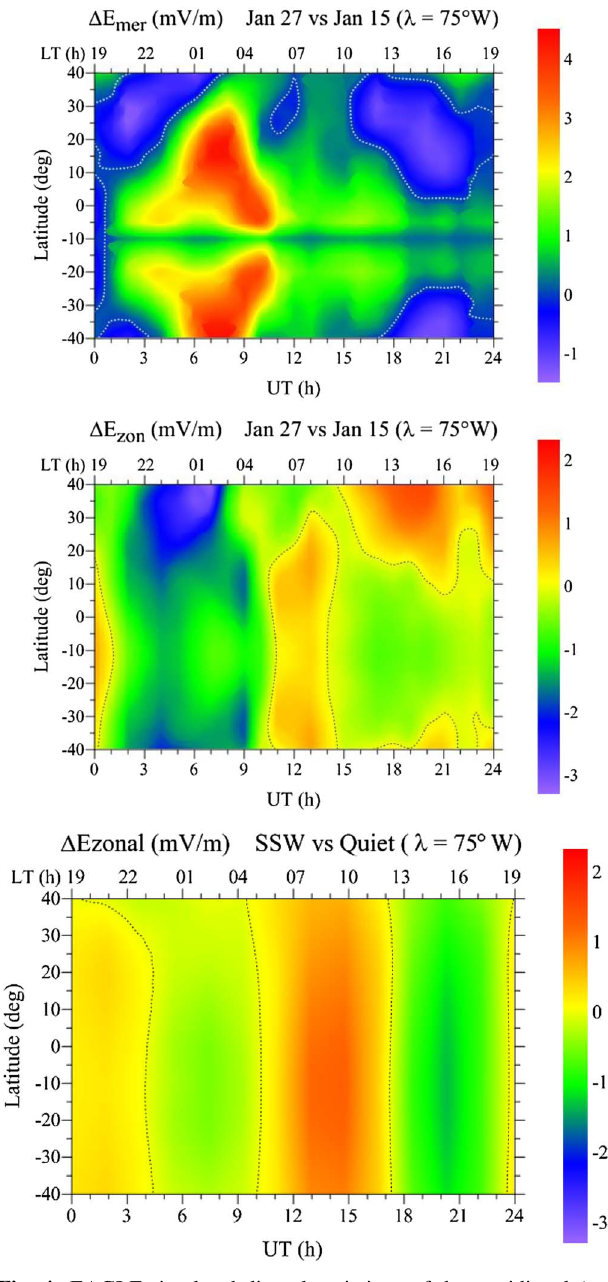
Fig. 4. EAGLE-simulated diurnal variations of the meridional (top panel) and zonal (middle panel) electric fi eld disturbances on 27 January 2009 at 40 (cid:3) S – 40 (cid:3) N latitudes in the American longitudinal sector (75 (cid:3) W) and 175 km altitude. The bottom panel presents the zonal electric fi eld disturbances that were obtained with the stand- alone GSM TIP model using the TIME-GCM model output with an additional electric potential that allowed for the reproduction of TEC disturbances during the 2009 SSW event (Klimenko et al.,